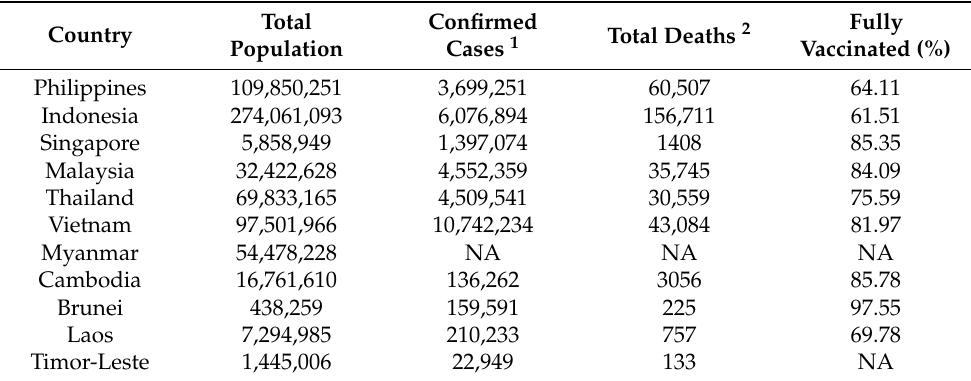
Table 1. COVID-19 cases, deaths and vaccination rates in S.E. Asia region (25 June